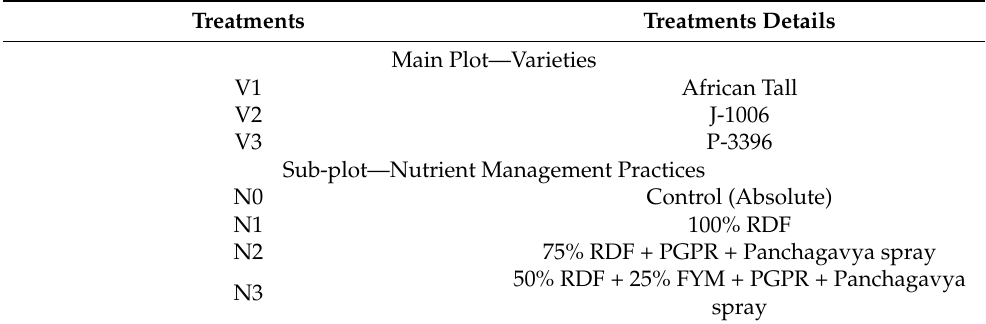
Table 1. Details of the varieties and nutrient management practices adopted in the fodder maize ex-